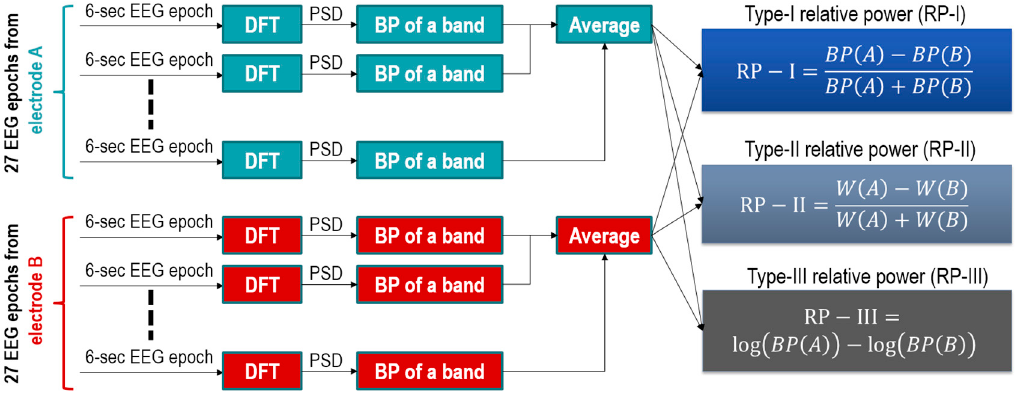
Figure 5. Illustration of the calculation of three types of relative powers in a specific frequency band between a pair of electrodes A and B. DFT = discrete Fourier transform; PSD = power spectrum density, and BP = band power.